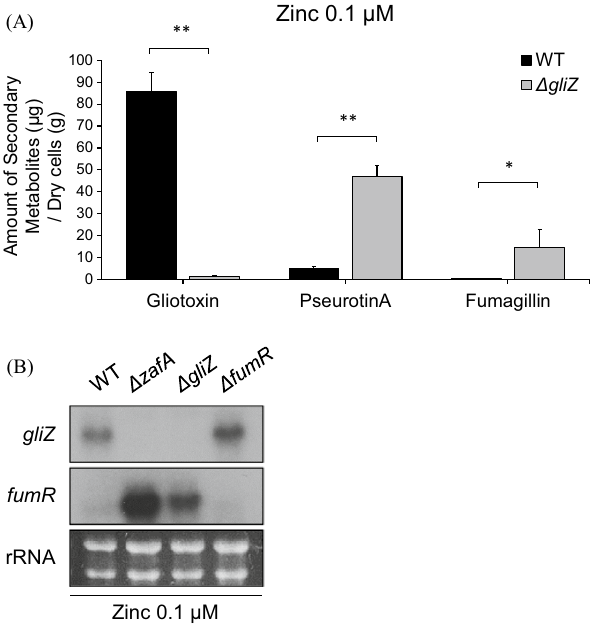
Figure 4. Pseurotin A biosynthesis was regulated by GliZ. ( A ) For identification of the effect of gliotoxin on pseurotin A biosynthesis, pseurotin A was measured in the wild-type and gliZ deletion mutant culture media. The indicated strains were cultured in Czapek-Dox media, and secondary metabolites were extracted from the culture media. Then, gliotoxin, pseurotin A, and fumagillin were measured using HPLC. The black and gray columns indicate wild-type and gliZ deletion mutants, respectively. * p < 0.05 and ** p < 0.01 indicate a significant difference compared to the control group. ( B ) Then, the gene expression levels of gliZ and fumR were investigated. The wild-type and indicated deletion strains were cultured in Czapek-Dox media, and total RNA was extracted from the cells. Then, northern blotting was performed against gliZ and fumR . rRNA was used as a loading